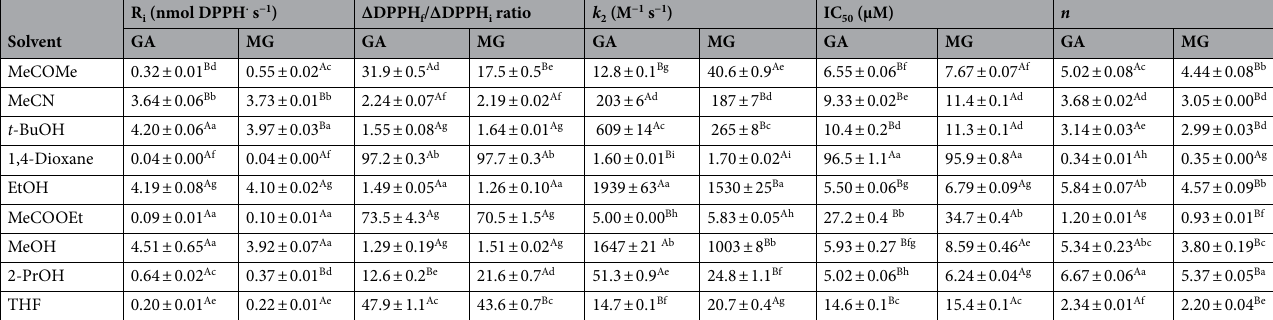
Table 4. The initial reaction rates (R i ) at an equal (60 μM) concentration of DPPH · and the antioxidants, the ratio between the final [DPPH · ] drop after 60 min of the reaction and the initial [DPPH · ] drop at t = 30 s, the second-order rate constants ( k 2 ), the antioxidant concentration required for scavenging 50% of the initial [DPPH · ] (IC 50 ), and the number of the mole DPPH · reduced by one mole of antioxidant ( n ) for the reaction between DPPH · and the antioxidant gallic acid (GA) or methyl gallate (MG) in the different reaction solvents. Means ± SD (standard deviation) within a column with the same lowercase letters are not significantly different at P < 0.05. Means ± SD (standard deviation) within a row for each kinetic parameter with the same uppercase letters are not significantly different at P <